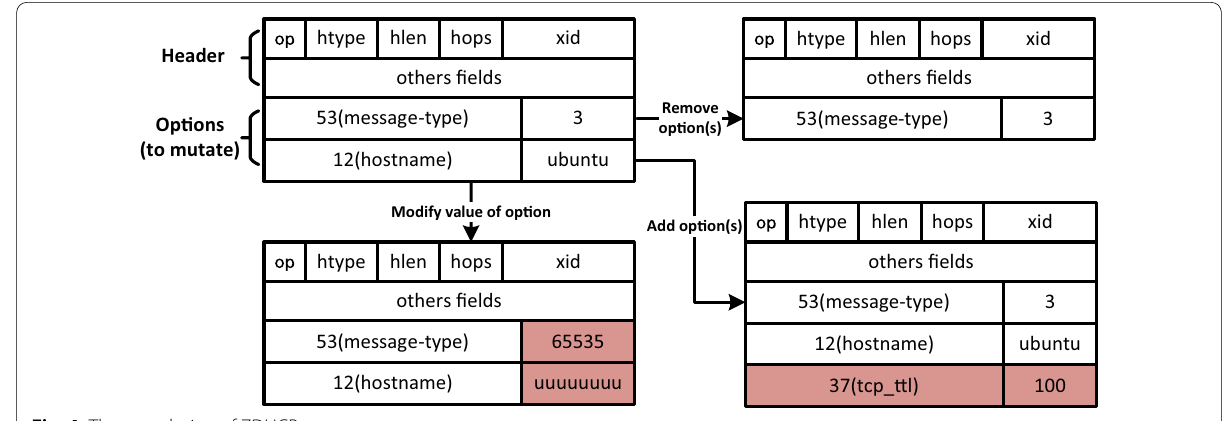
Fig. 4 The core design of